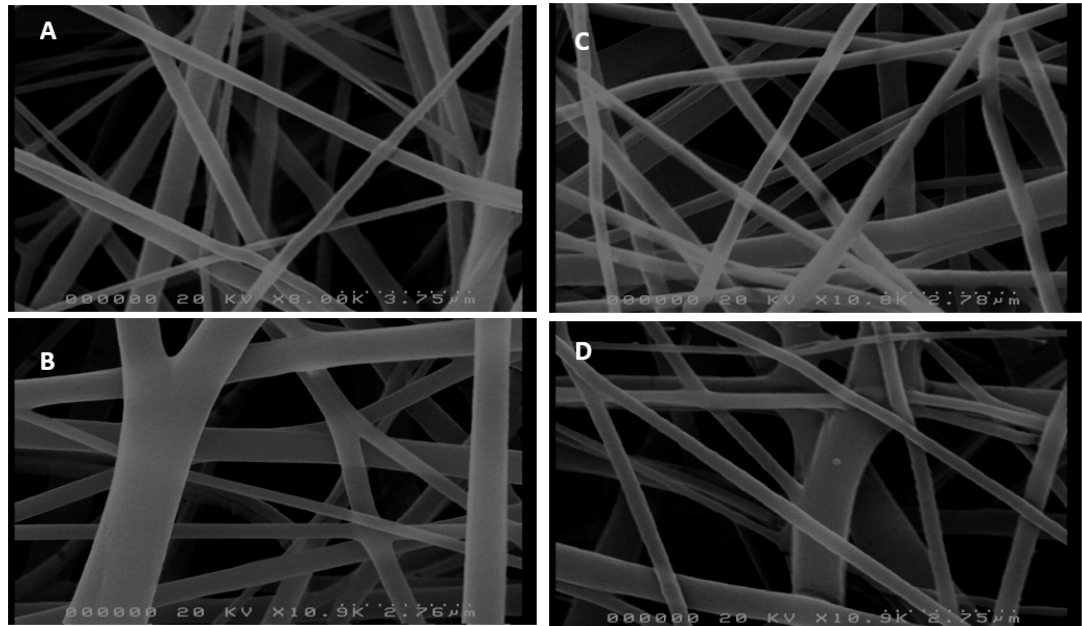
Figure 2 . SEM images of the PCL/gelatin (90:10 %w/v) composite nanofibers electrospun at ( A ) 18 kV, ( B ) 20 kV, ( C ) 22 kV, and ( D ) 24 kV voltages. The images were measured at a magnification of ×8000 to ×10,000.